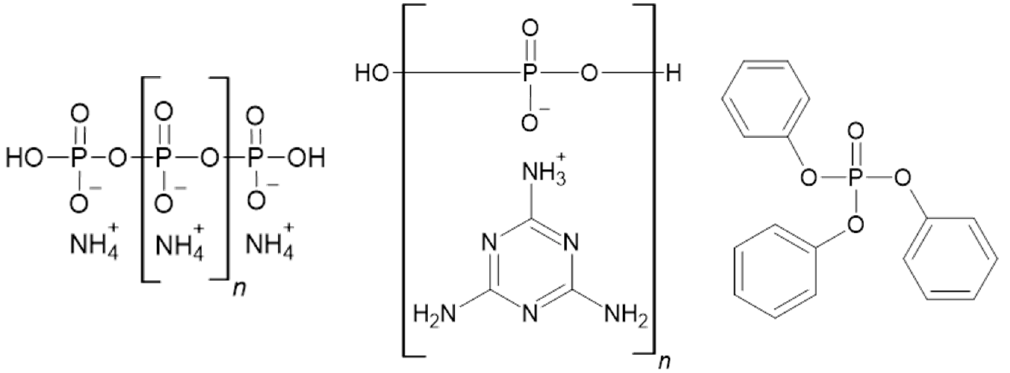
Figure 4. Structures of ammonium polyphosphate [58], melamine polyphosphate [59] , and triphenyl phosphate [60].